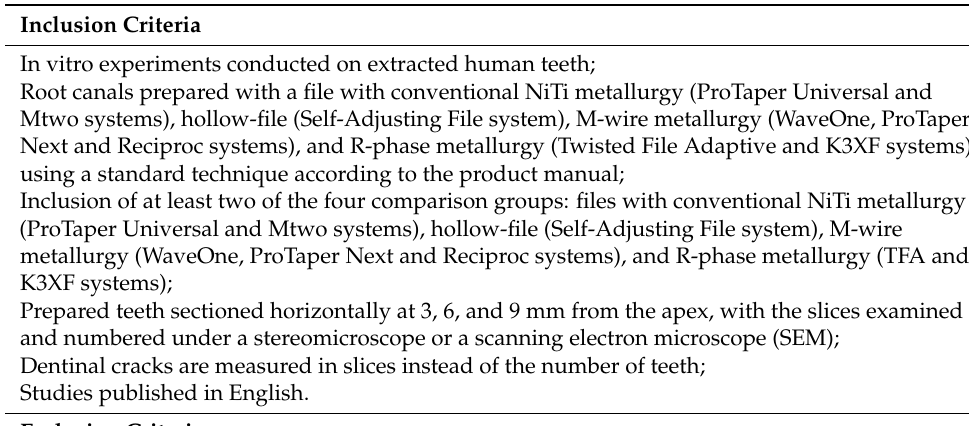
Table 2. Inclusion and exclusion criteria